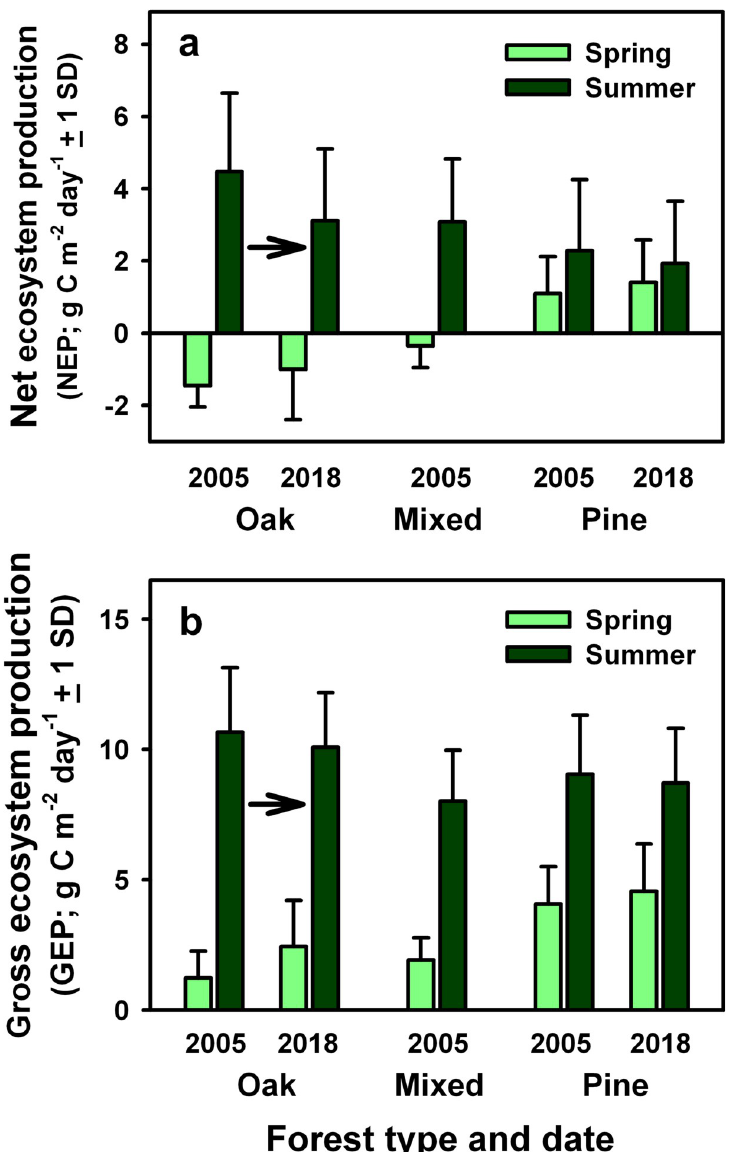
Fig 5. Productivity of the oak, mixed, and pine stands before L . dispar infestations in 2005 and following L . dispar infestations in 2018. Data are presented for (A) daily net ecosystem production, (B) daily gross ecosystem production during late spring (April 1 to May 15) and summer (June 1 to August 31) months. Arrows indicate the directional changes in forest structure and composition following L . dispar infestations. Pre-infestation data are adapted from Clark et al. [13,